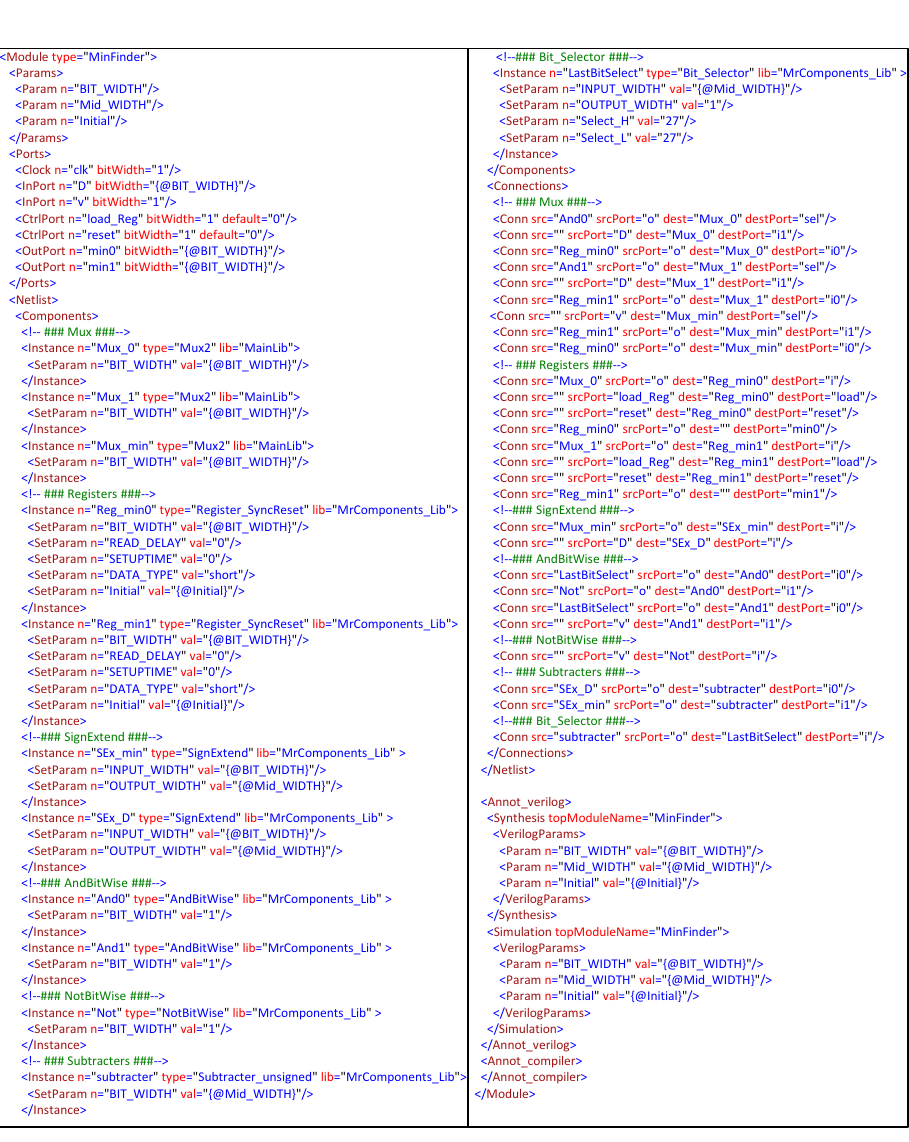
Figure 8. “MinFinder” module generic netlist representation (GNR) hierarchical